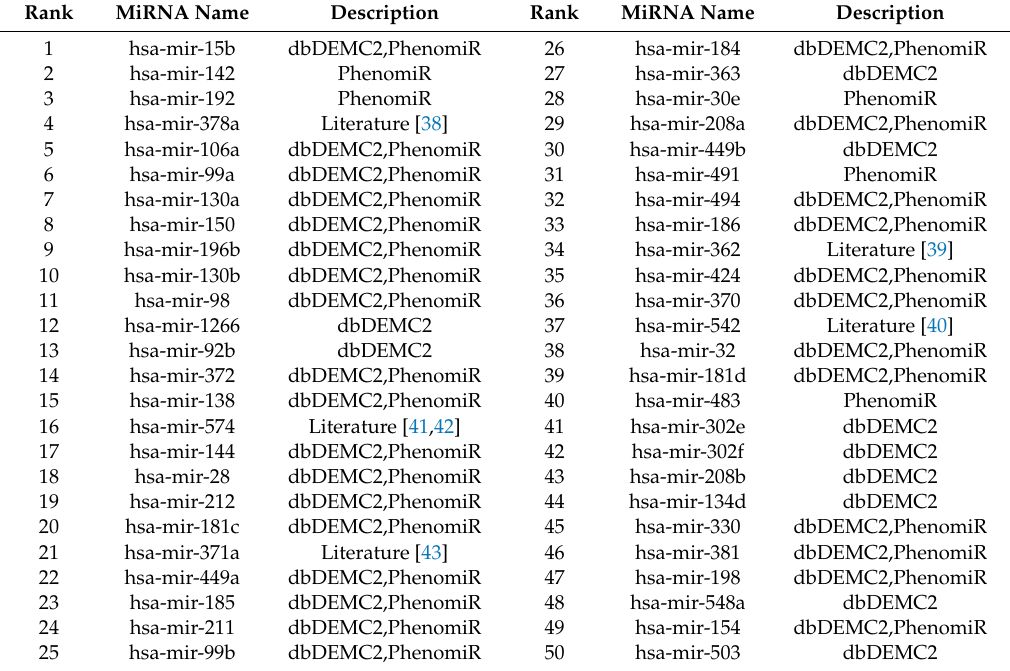
Table 4. The top 50 candidates related to breast neoplasms.